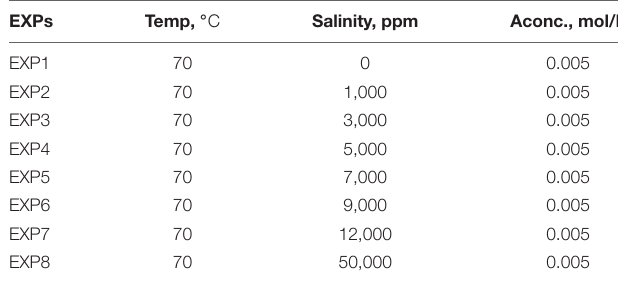
TABLE 11 | Na 2 CO 3 concentration trend study experiment design.